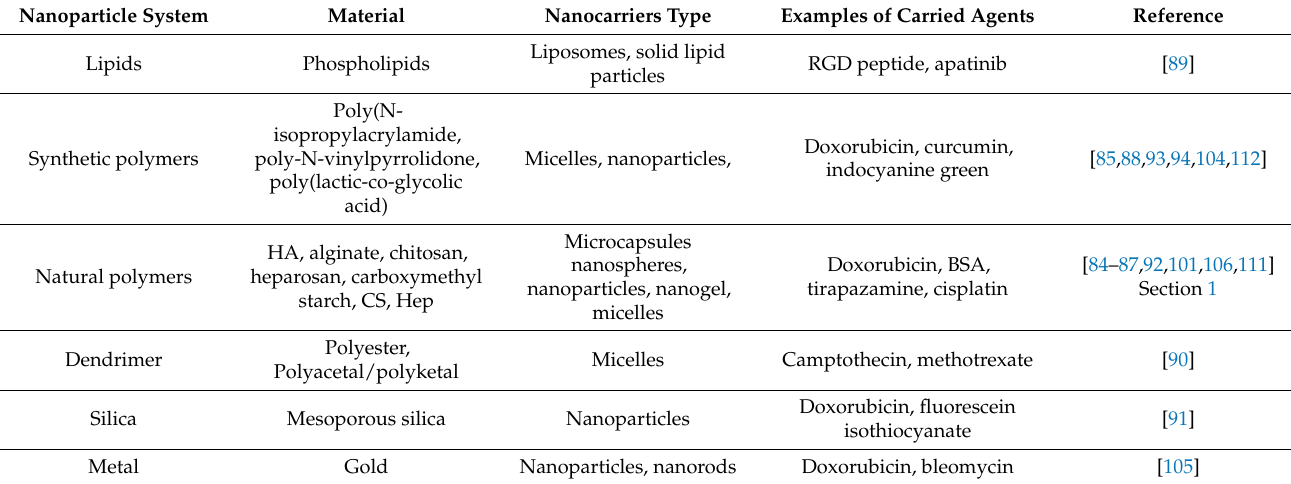
Table 1. Types of nanoparticles and materials utilized for targeted drug